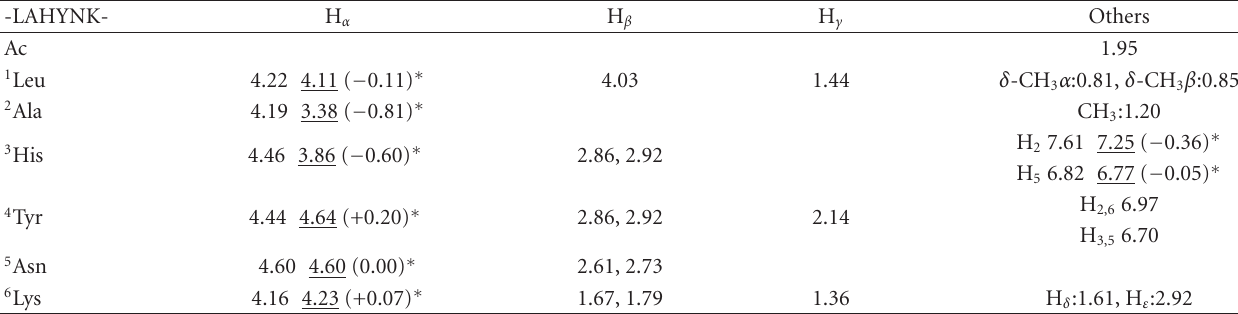
Table 1: Chemical shifts of 1 H( δ , ppm) of free and Ni(II)-bound -TYTEHA-, in a metal:peptide ratio 1 : 1, at pH ∗ 9.5. -LAHYNK- H α H β H γ Others